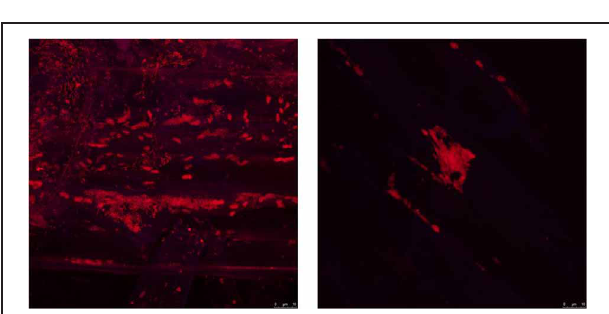
FIGURE 4 | The impact of salt stress on the capability of S. rhizophila DSM14405 T to colonize the oilseed rape rhizosphere visualized using FISH-CLSM. S. rhizophila DSM14405 T intensely colonizes the oilseed rape rhizosphere (left) while the treatment of seeds with 1.25% NaCl (right) severely decreases the colonization capability. An equimolar ratio of the FISH probes EUB338, EUB338 II, and EUB338 III labeled with the fluorescent dye Cy3 was used in the hybridization step. Microscopic images were captured using a Leica TCS SPE confocal microscope. The Leica ACS APO 63X OIL CS objective (NA: 1.30) was used to acquire confocal stacks by applying a z-step of 0.4–0.8 µ